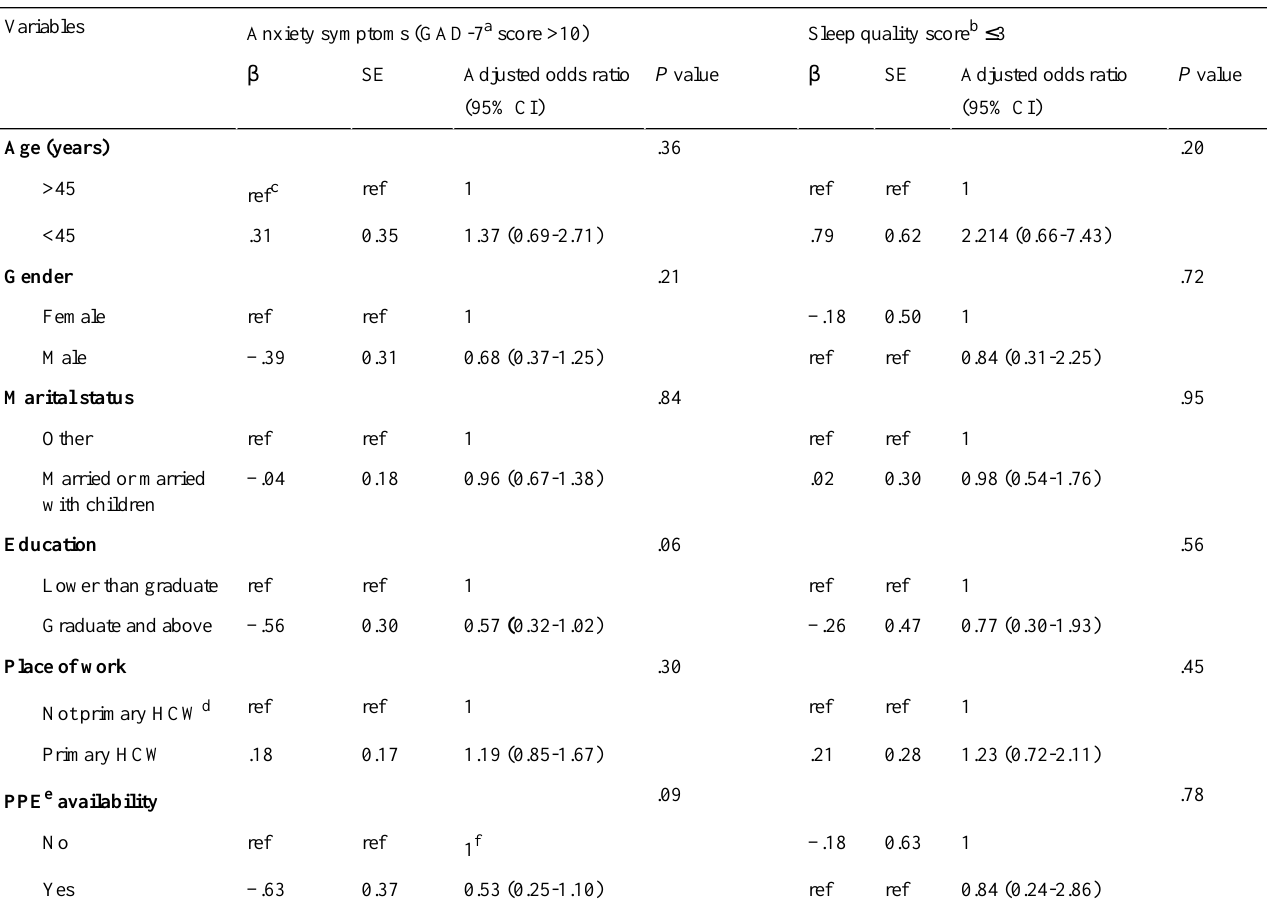
Table 4. Factors influencing anxiety and sleep quality among health care workers.